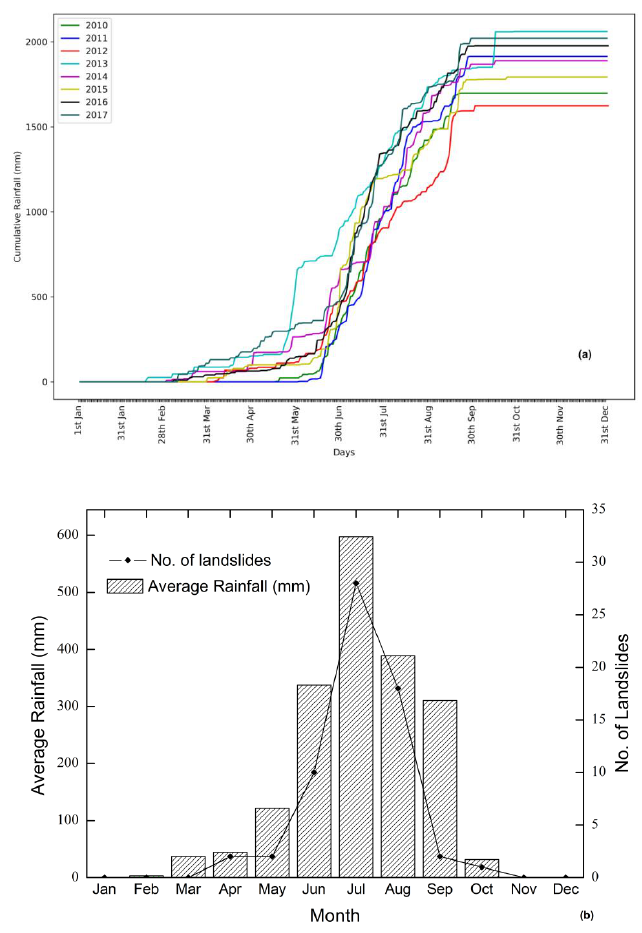
Figure 2. ( a ) Yearly cumulative rainfall; ( b ) Monthly distribution of landslide occurrence and average rainfall, (2010–2017) in